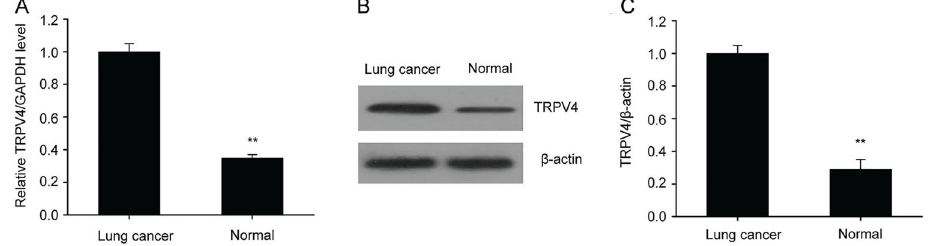
Figure 1. TRPV4 downregulation in lung cancer (LC) samples. A , qRT-PCR was carried out to evaluate TRPV4 expression in both LC tissues and surrounding non-malignant tissues (normal). B and C , Representative immunoblots and quantitative assessment of TRPV4 in human LC tissues and in surrounding non-malignant tissues (normal). Data are reported as means ± SE (n=15). **P o 0.01 ( t -test).